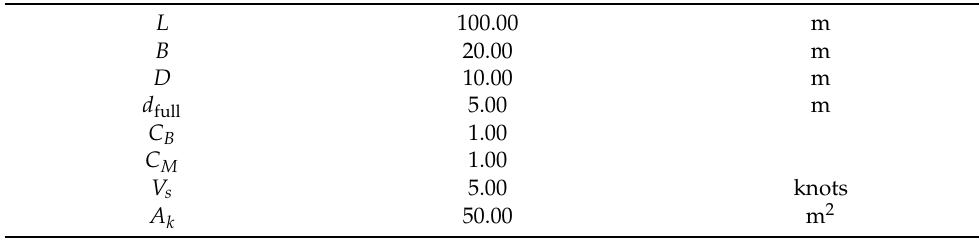
Figure 15. Isometric view of barge geometry in a section-based GF format. Blue lines mark the deck edge. See Section 6 for a link to download this geometry file. Table 3. Principal dimensions of barge.